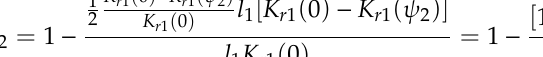
Figure 6. The distribution of relative hydraulic conductivity in the first layer when the buried depth